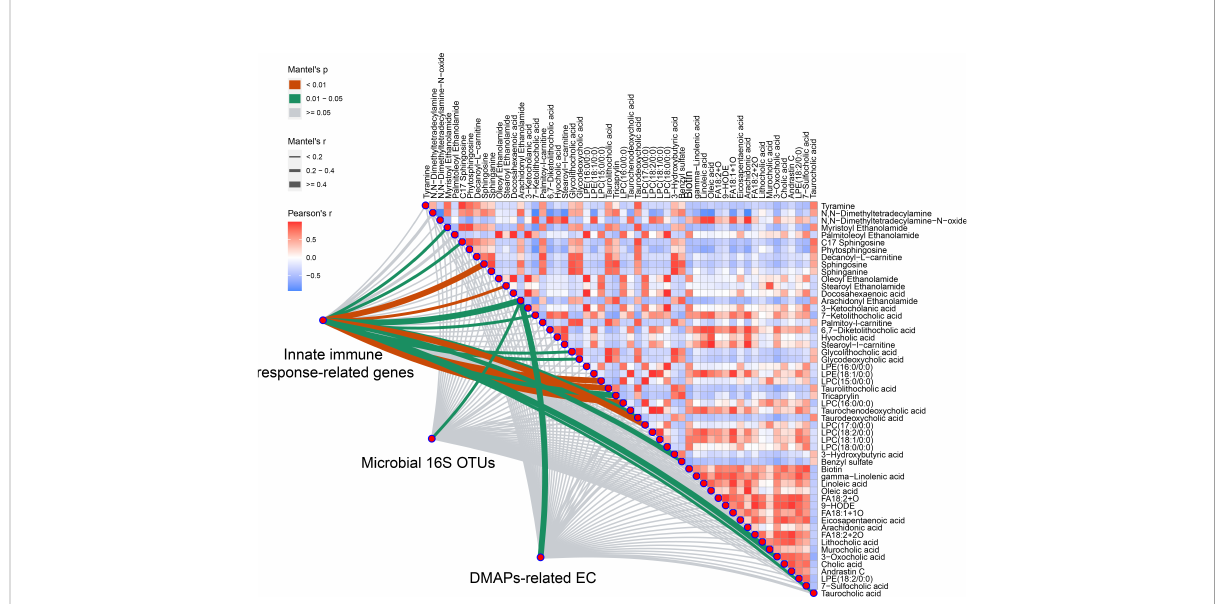
FIGURE 7 Variations of microbiome with DAMPs-related enzymes and duodenal metabolites have signi fi cant relationship with innate immune response- related genes expression. Integrated analysis of multi-omics data was performed using Mantel test. AEA was selected from all the three pro fi les (Mantel ’ s p < 0.05 represent signi fi cant) ( n = 5